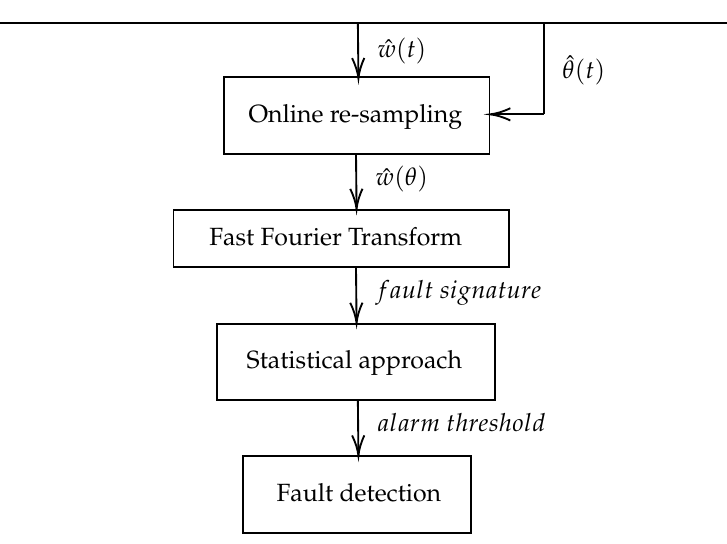
Figure 1. Flowchart of the proposed